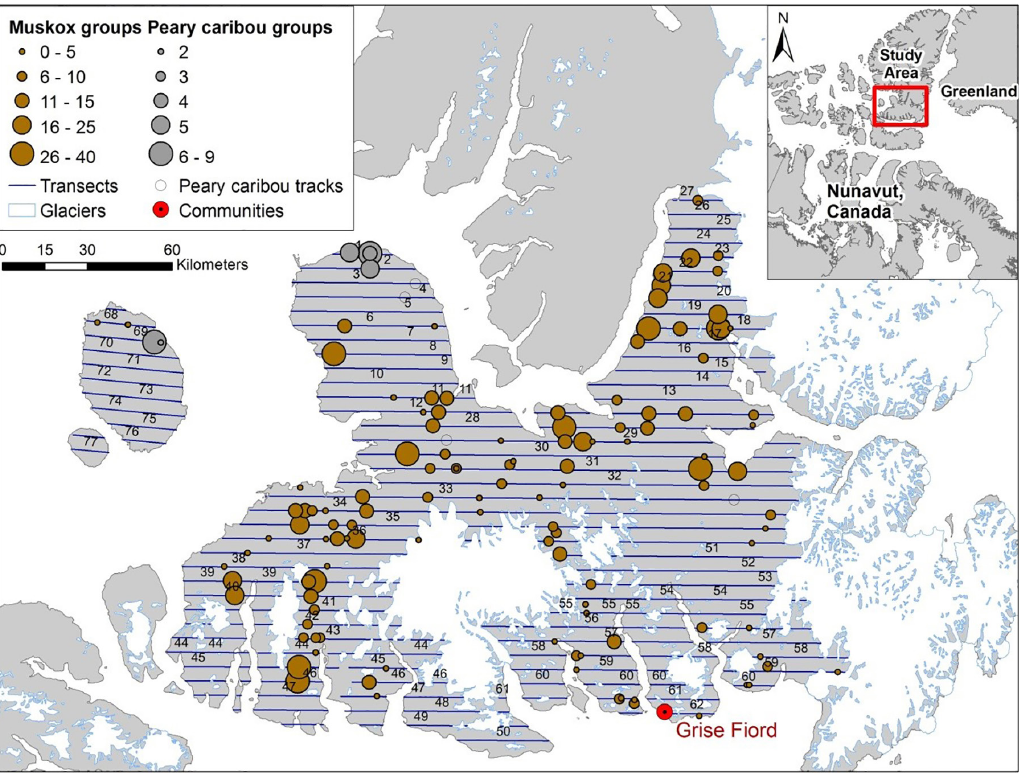
Figure 3. Observations of Peary caribou and muskoxen on southern Ellesmere, Graham, and Buckingham islands during the March 2015 aerial survey. Flight transects are labelled by